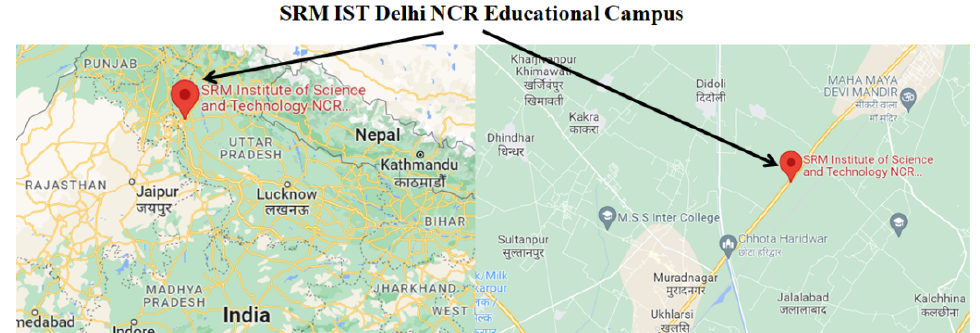
Figure 1. Map showing the location of SRM IST, Delhi ‐ NCR Educational Campus.